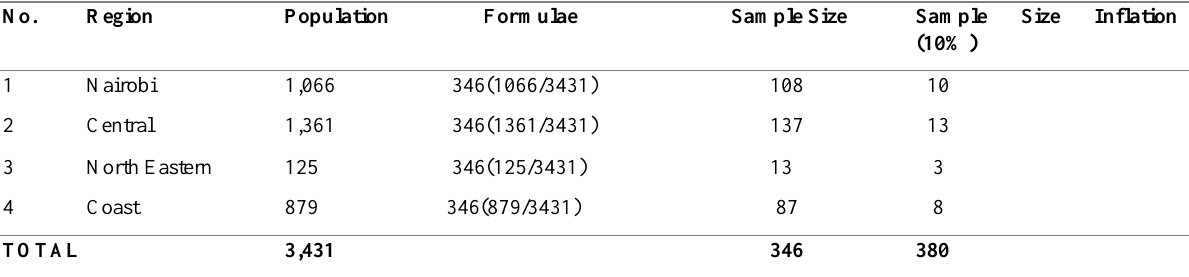
Table 1: Sample Size